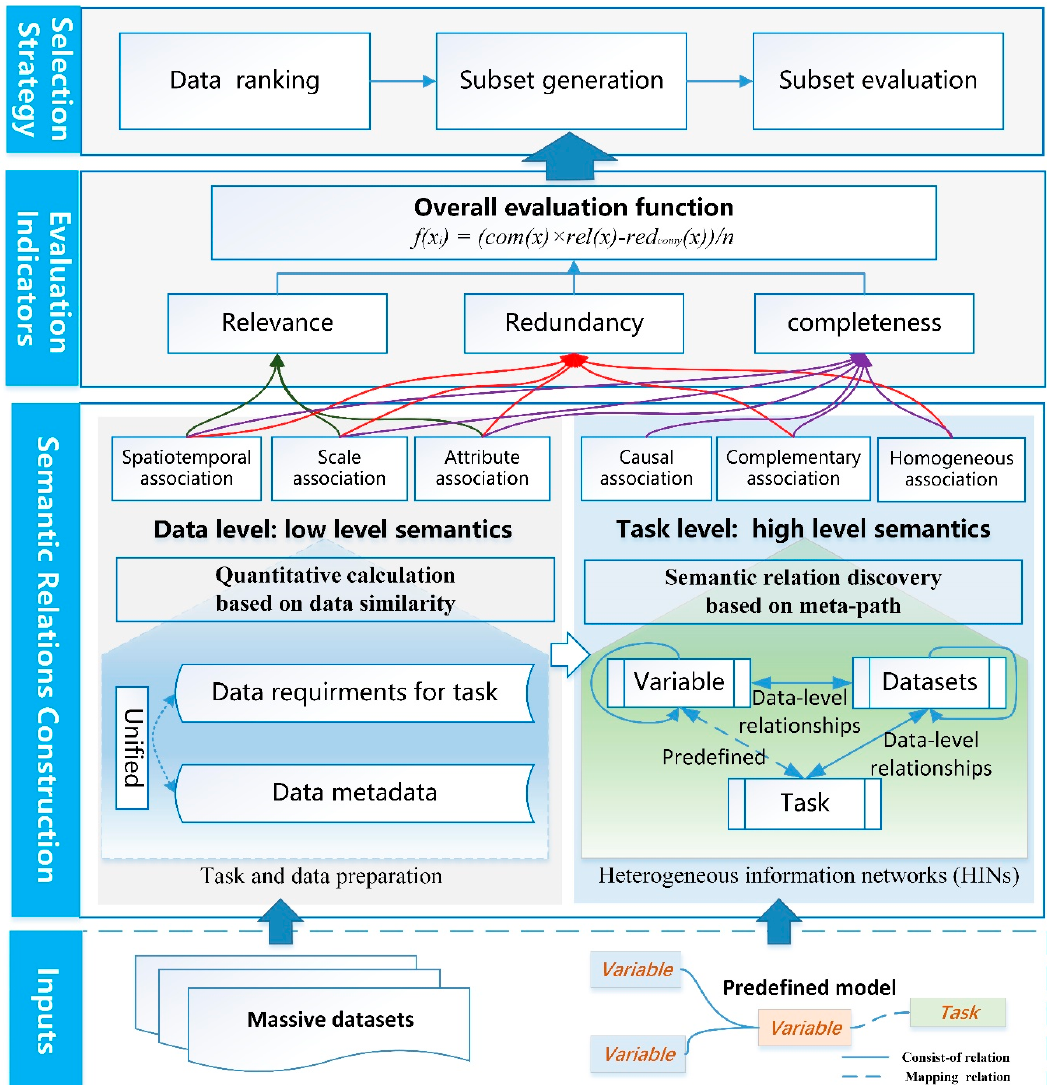
Figure 1. Computational framework of semantics-constrained advantageous information selection.